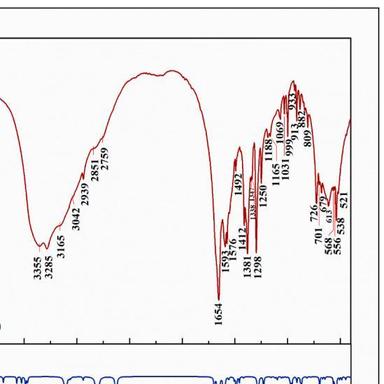
Ftir spectra of GuHM (a) experimental (b) theoretical.